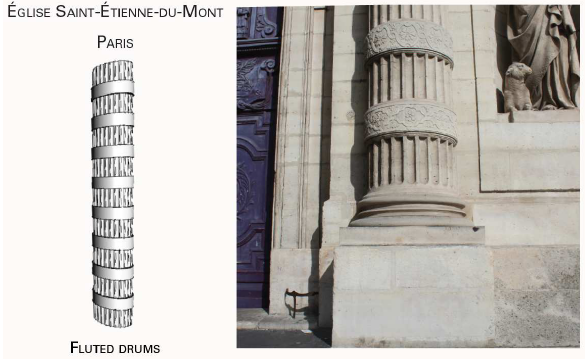
Figure 12. Implementation of fluted drums